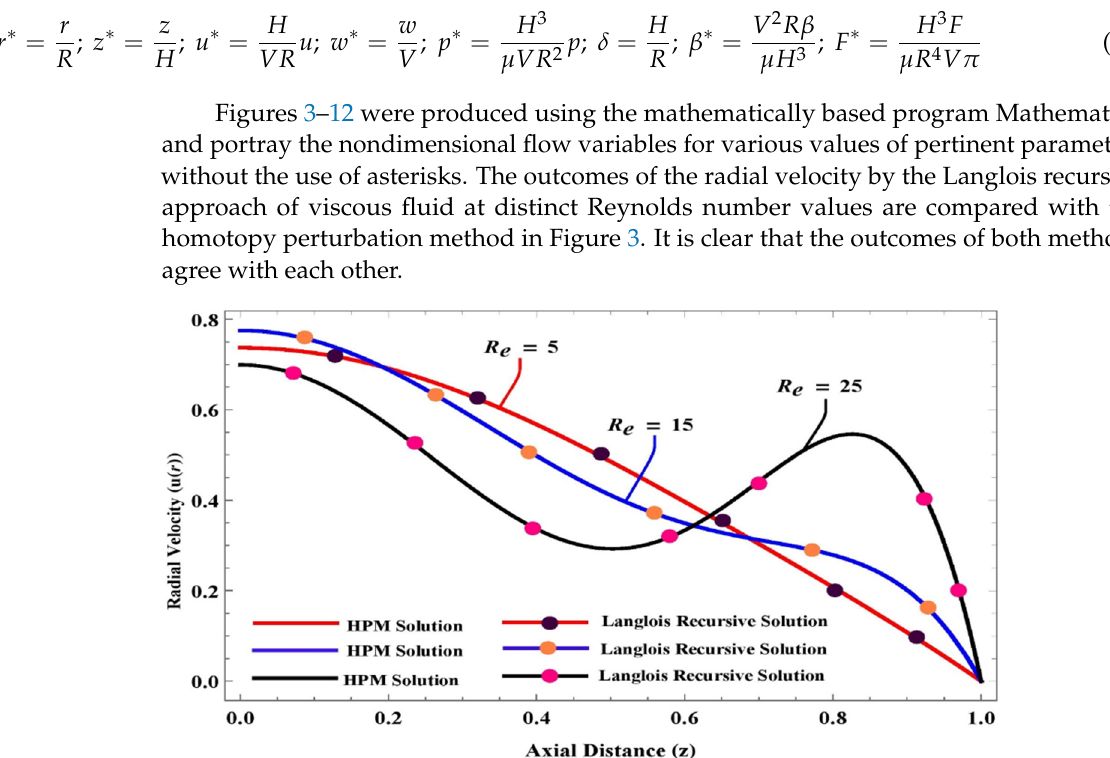
Figure 3. Comparison between homotopy perturbation method (HPM) [40] and Langlois recursive solutions for viscous fluid ( β = 0 ) at different Reynolds number